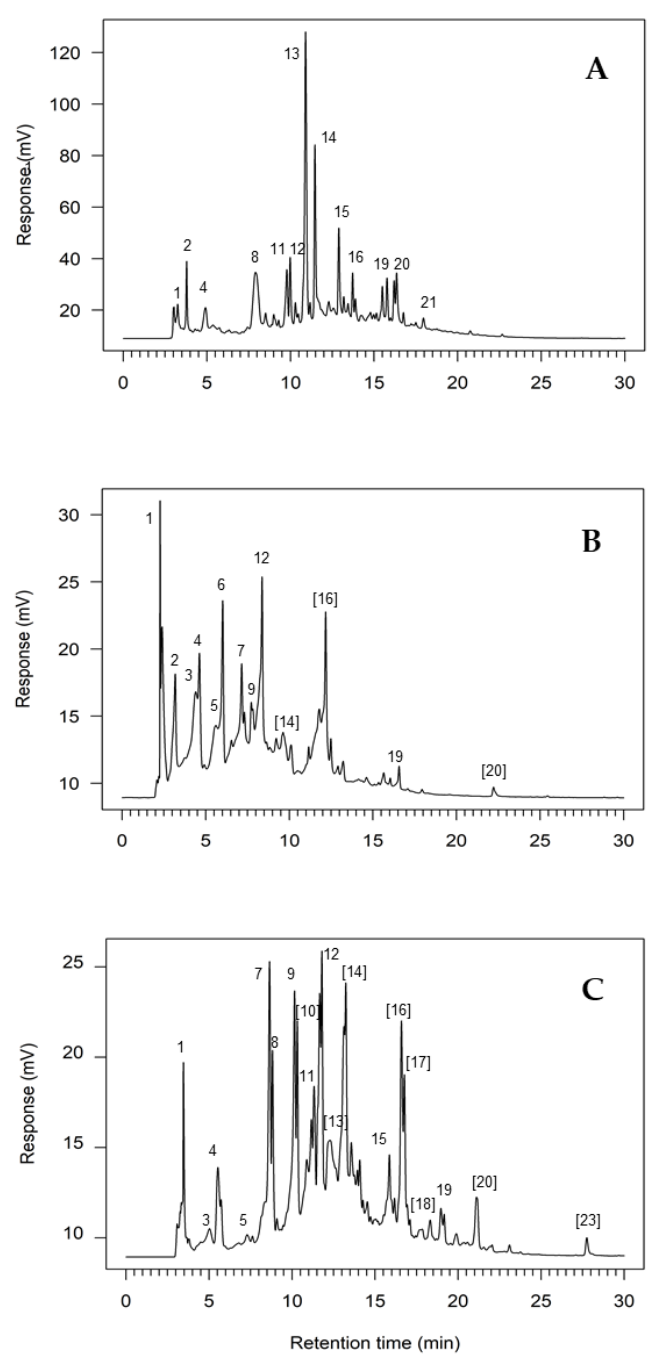
Figure 3. Chromatographic profiles of distillation wastewaters and hydroalcoholic extracts of distilled straws obtained after essential oil distillation from flowers of Lavandula angustifolia cultivar Rosa. ( A ): distillation wastewater (LEACH); ( B ): PUAE of dry distillation straws (TWE) in 70:30 ethanol:water; (C): PUAE of dry petals from distillation straws (FWE) in 70:30 ethanol:water. Chromatograms were obtained at 280 nm wavelength after RP-HPLC. Note that retention times may vary for the same compounds depending on the specific laboratory conditions during the analysis. Numbers within square brackets indicate unidentified compounds. Peak numbers correspond to those reported in Table 3. The studied compounds differed in molecular weight and structure and not all of them showed maximum absorbance at 280 nm wavelength; therefore, observed peak areas and/or peak heights do not necessarily match calculated concentrations.